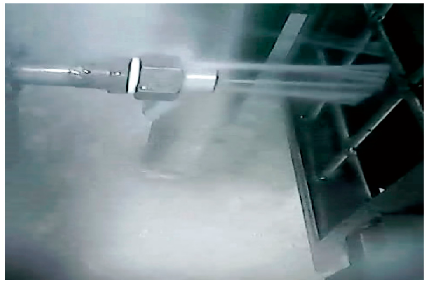
Figure 11. The high-pressure water jet cutting into the oil shale sample.